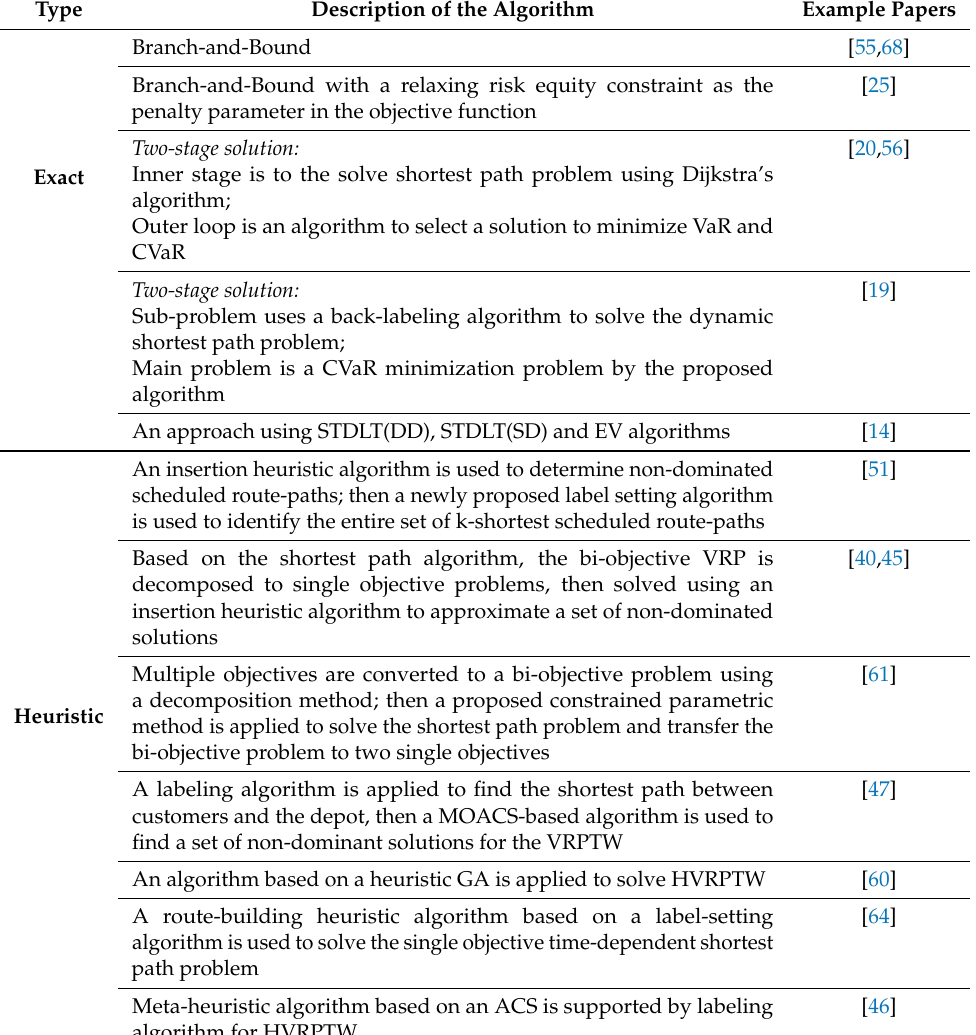
Table 5. Algorithms used in the mathematical/optimization models accounting for crash risk. Type Description of the Algorithm Example